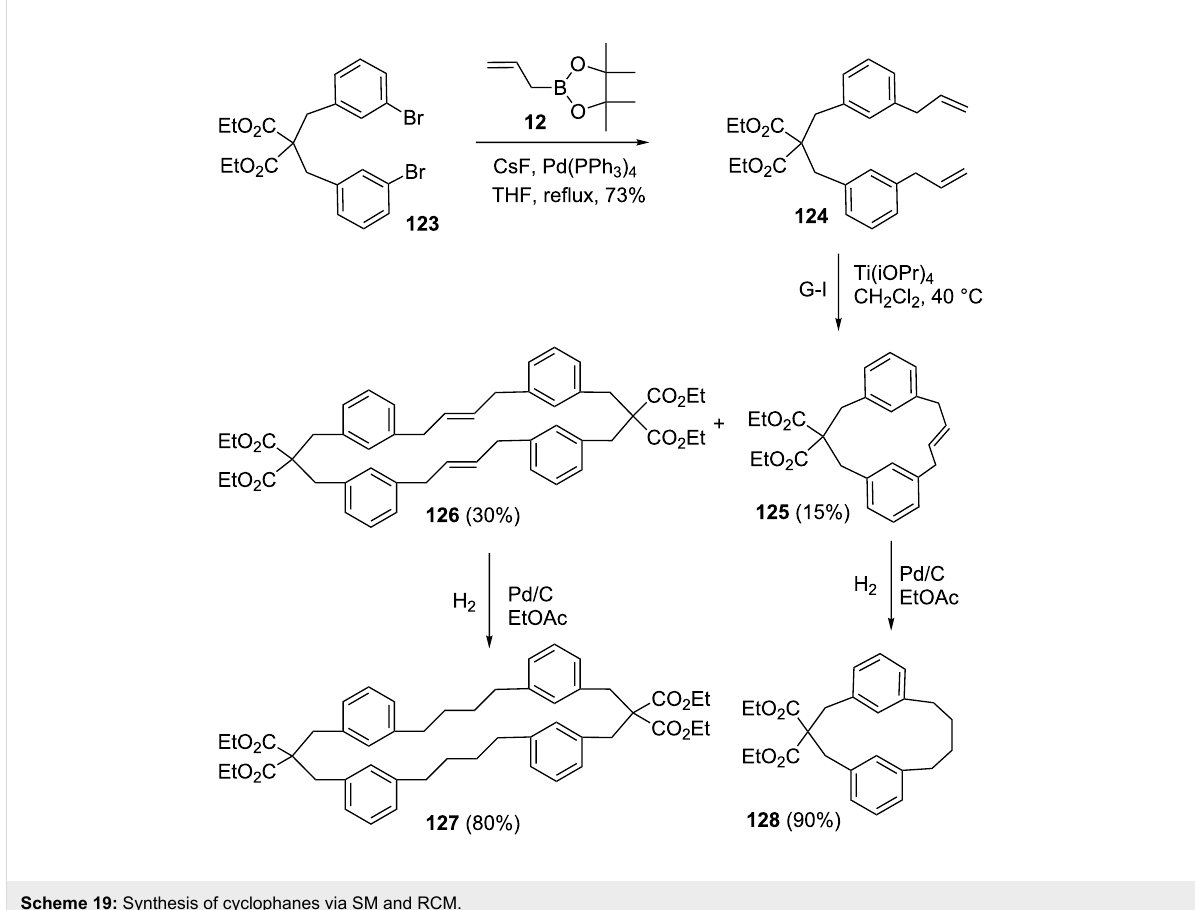
Scheme 19: Synthesis of cyclophanes via SM and